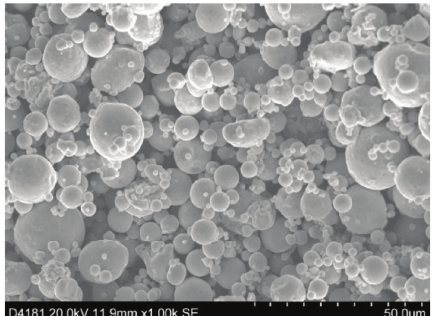
Figure 1: SEM micrograph of Inconel 718